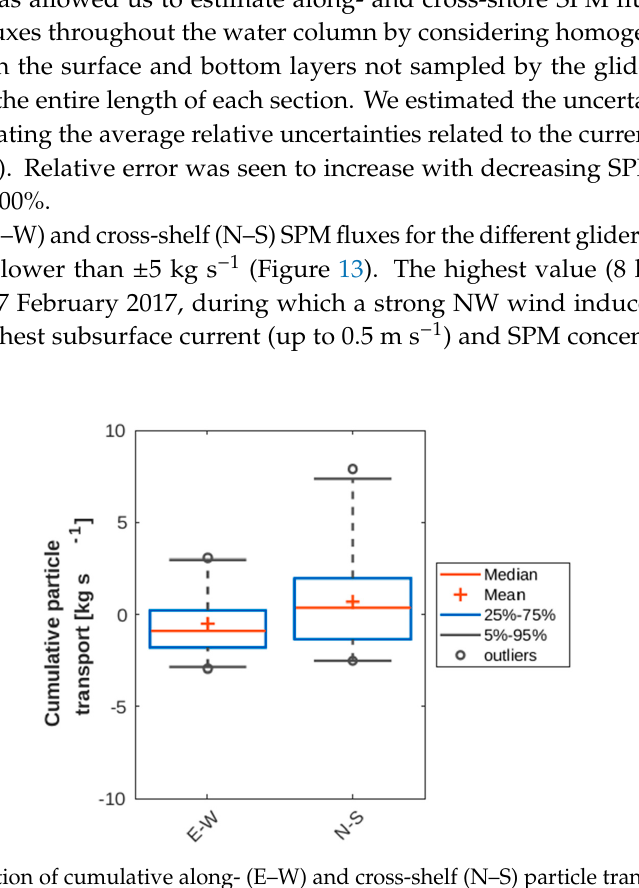
Figure 13. Distribution of cumulative along- (E–W) and cross-shelf (N–S) particle transport (kg s − 1 ) for all the sections performed during autumnal and winter deployments.